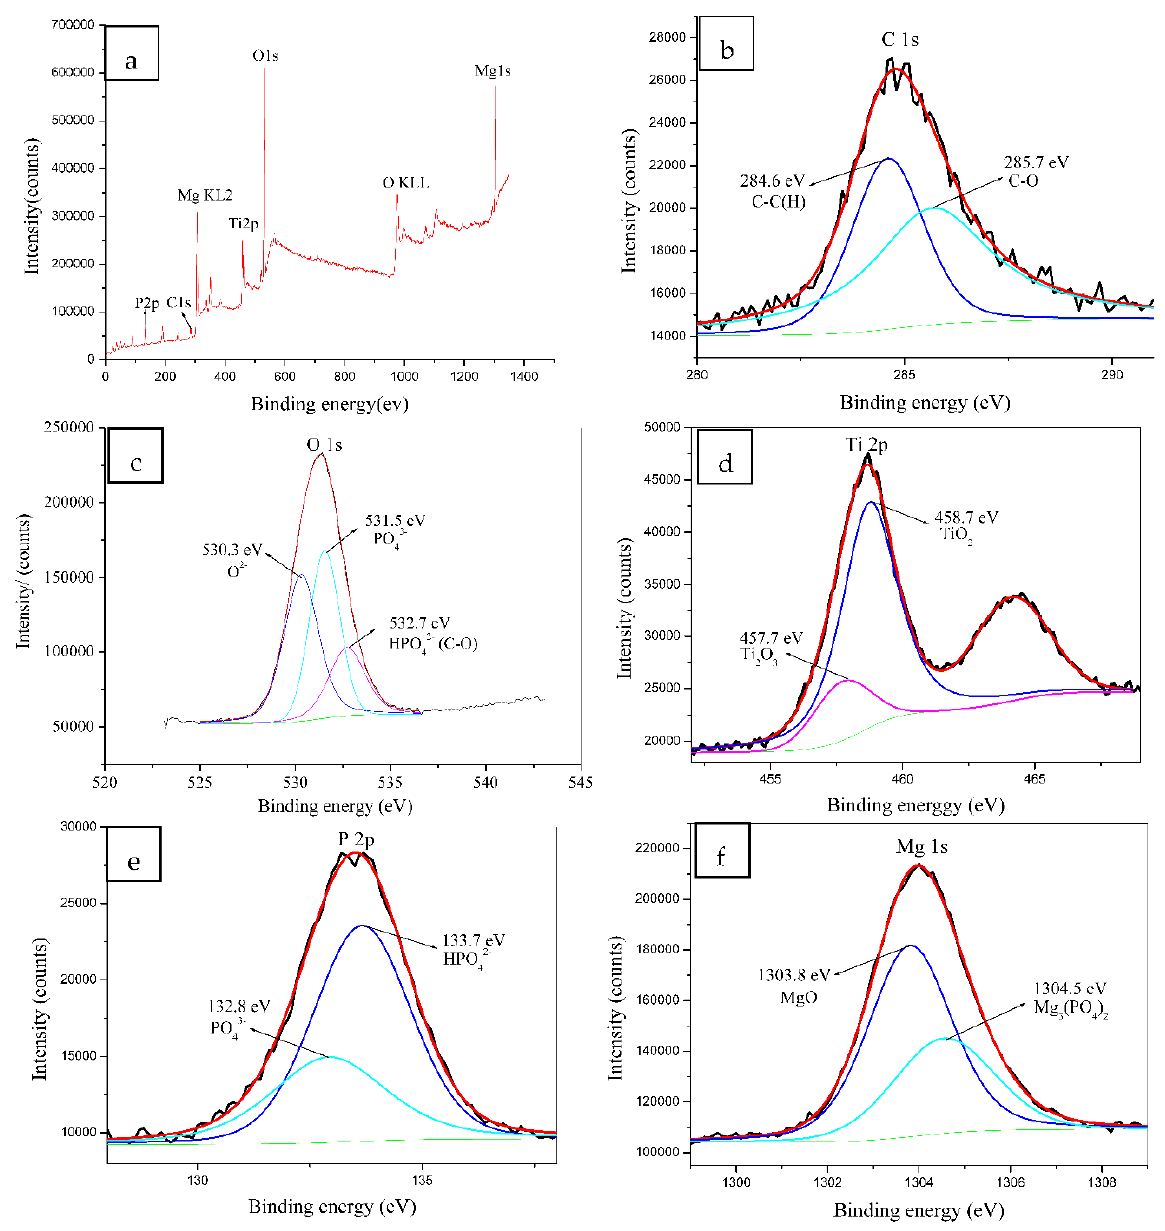
Figure 5. XPS spectra of the anodic coatings obtained at a current density of 50 mA/cm 2 , duty cycle of 35%, pulse frequency of 2000 Hz and treatment time of 3 min in the Mg-10-KOH-8 system: ( a ) survey, ( b ) C 1s, ( c ) O 1s, ( d ) Ti 2p, ( e ) P 2p and ( f ) Mg 1s.